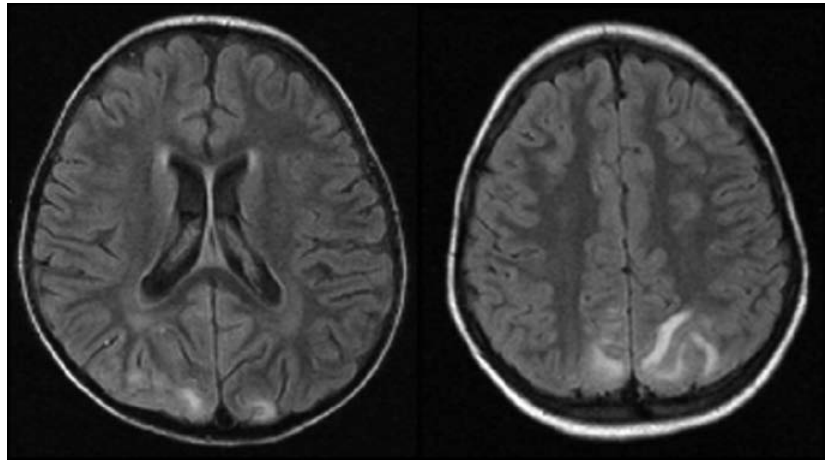
Figure 1. Brain magnetic resonance imaging (FLAIR) showing an increase of signal in both parieto-occipital